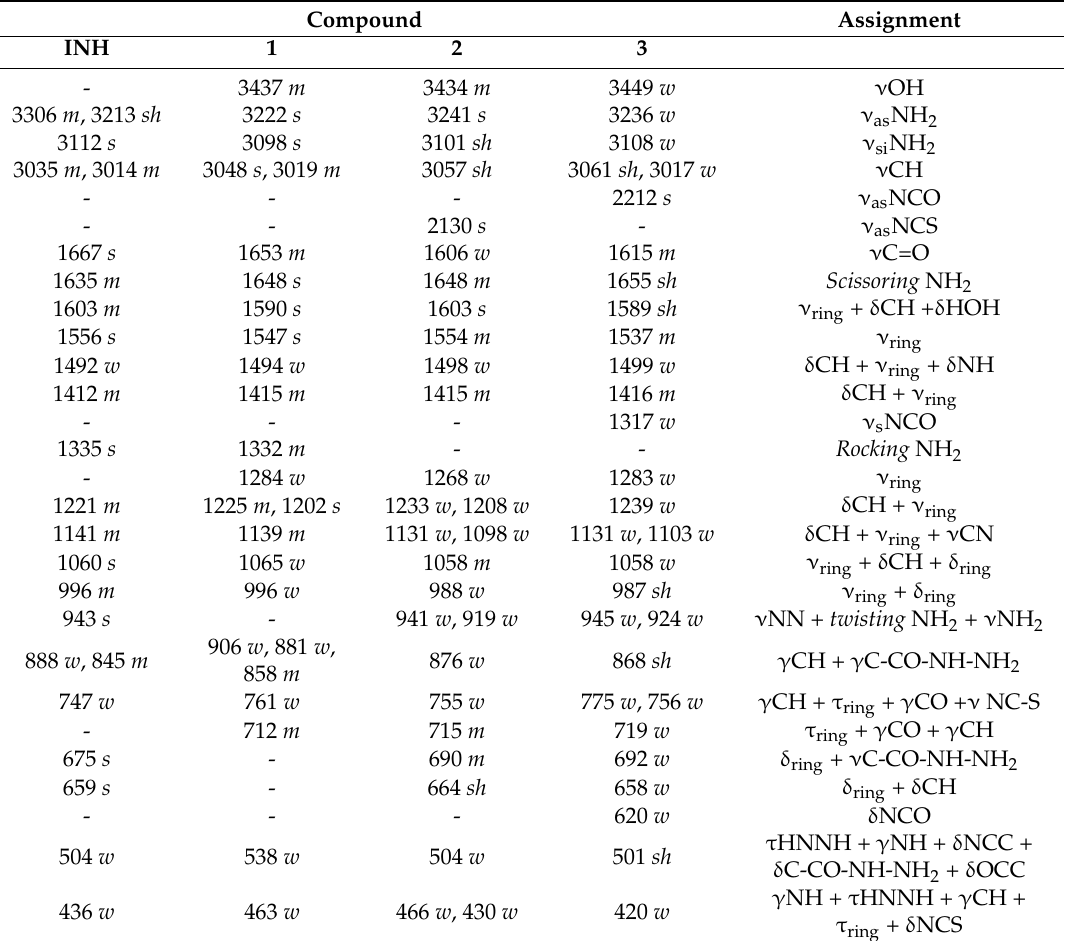
Table 1. Selected vibrational data (cm ´ 1 ) and assignments for isoniazid (INH) and the Cu(II) compounds ( 1 – 3 ).